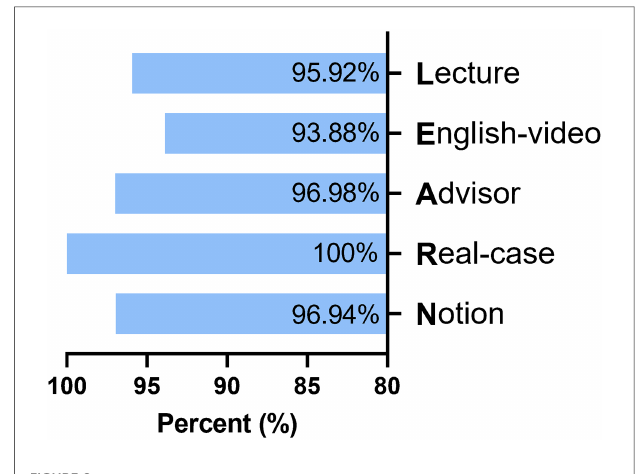
FIGURE 2 Students ’ rating of the fi ve